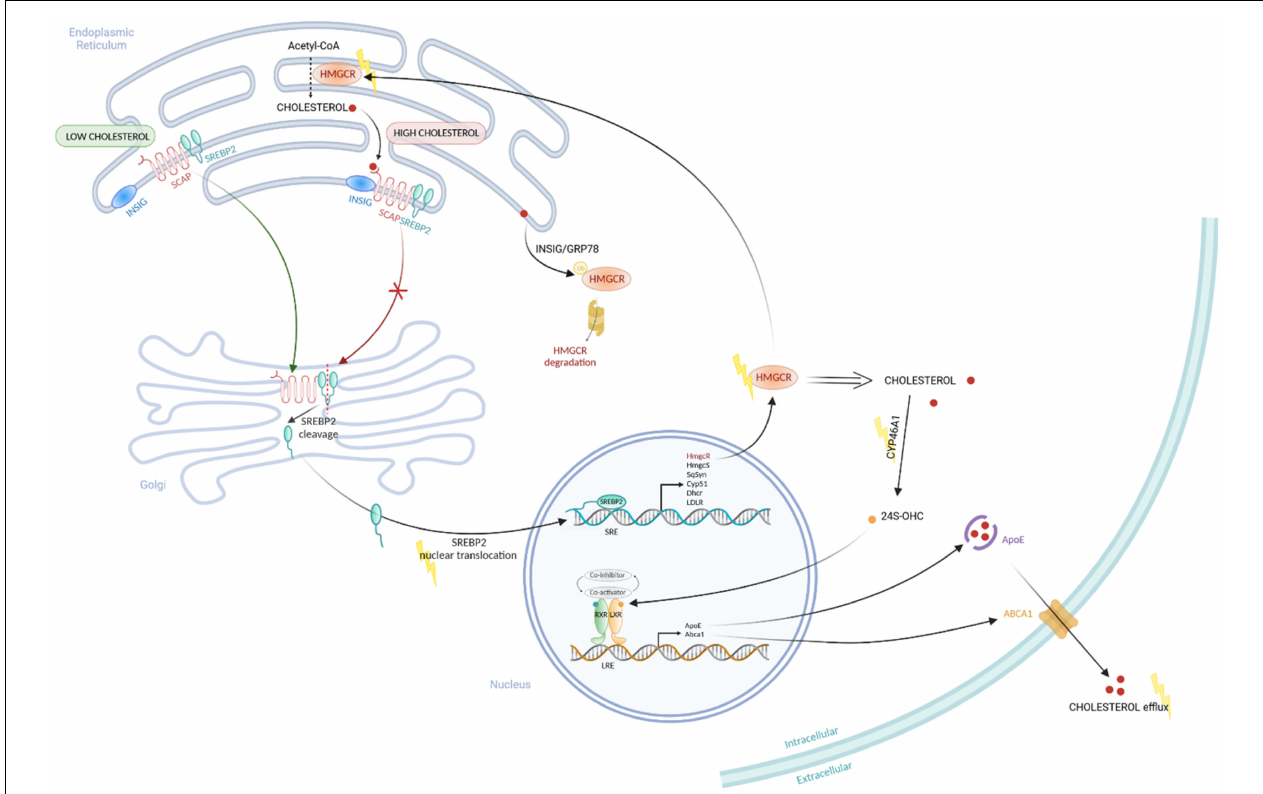
FIGURE 2 | Regulation of Cholesterol metabolism pathways. Cholesterol is synthesized in the endoplasmic reticulum (ER) from Acetyl-CoA through several steps using different enzymes, including the rate limiting enzyme HMGCOA-reductase (HMGCR). SREBP2 forms a complex with SCAP, a sensor of cholesterol, which is anchored at the ER membrane. When cholesterol is high, the sensor SCAP interact to INSIG protein, maintaining the SREBP2/SCAP complex at the ER membrane. When cholesterol level is low, SREBP2/SCAP complex can translocate to the Golgi where SREBP2 is activated by a cleavage. The activated SREBP2 can then translocate to the nucleus to induce the transcription of genes coding cholesterol synthesis enzymes, such as HMGCOA-reductase (HmcR), HMGCO-synthase (HmgcS), Squalen Synthas (SqSyn), Cyp51, Dhcr. This is associated to a negative feedback loop on cholesterol synthesis pathway. Sterol accumulation in the ER membrane triggers proteasome-mediated degradation of HMGCR through INSIG/GRP78-mediated mechanism. In parallel, the enzyme CYP46A1 can catalyze the cholesterol into 24S-OHC, a ligand of the nuclear receptor LXR. When the 24S-OHC binds to LXR, a co-activator is recruited and induce the transcription of genes involved in cholesterol efflux (Abca1, ApoE), leading to a decrease of intracellular cholesterol level. Yellow lightning points out altered functions in cholesterol metabolism in HD. Created with